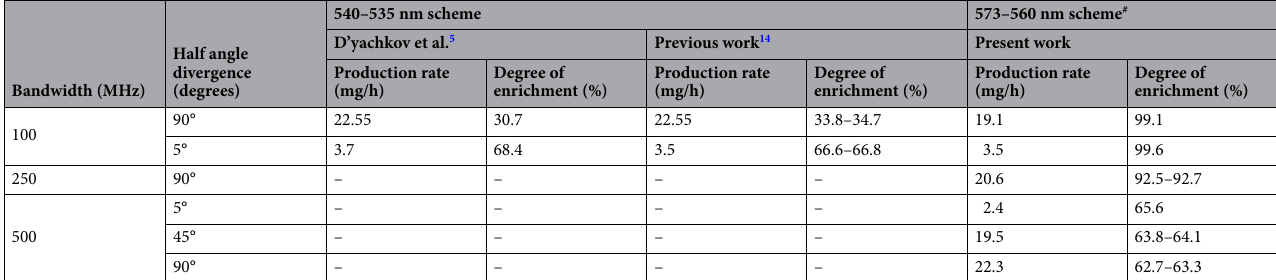
Table 5. Comparison of the photoionization schemes for the degree of enrichment and production rates of 176 Lu for various experimental parameters. # See Table 4 for laser peak power density of the